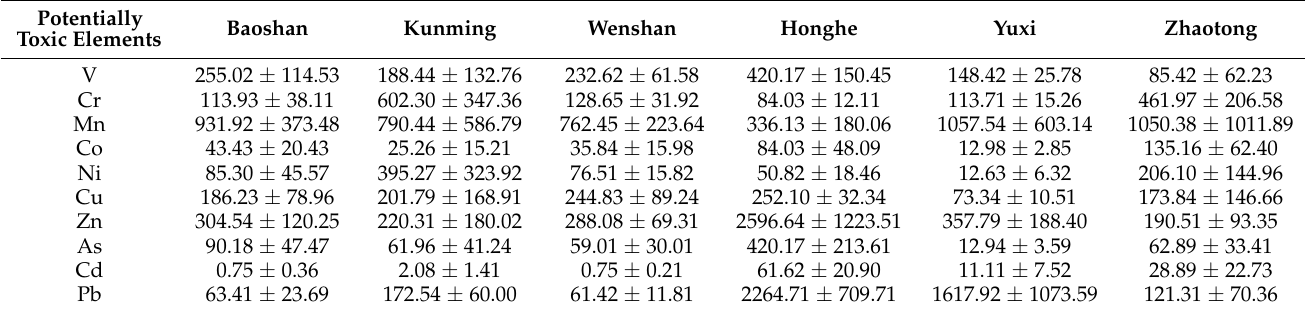
Table 2. Potentially toxic elements’ contents in PM 2.5 of soil fugitive dust (mean value ± standard deviation,